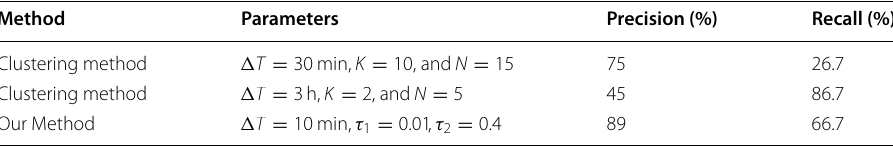
Table 13 Evaluation measures for event detection using our method and the clustering baseline